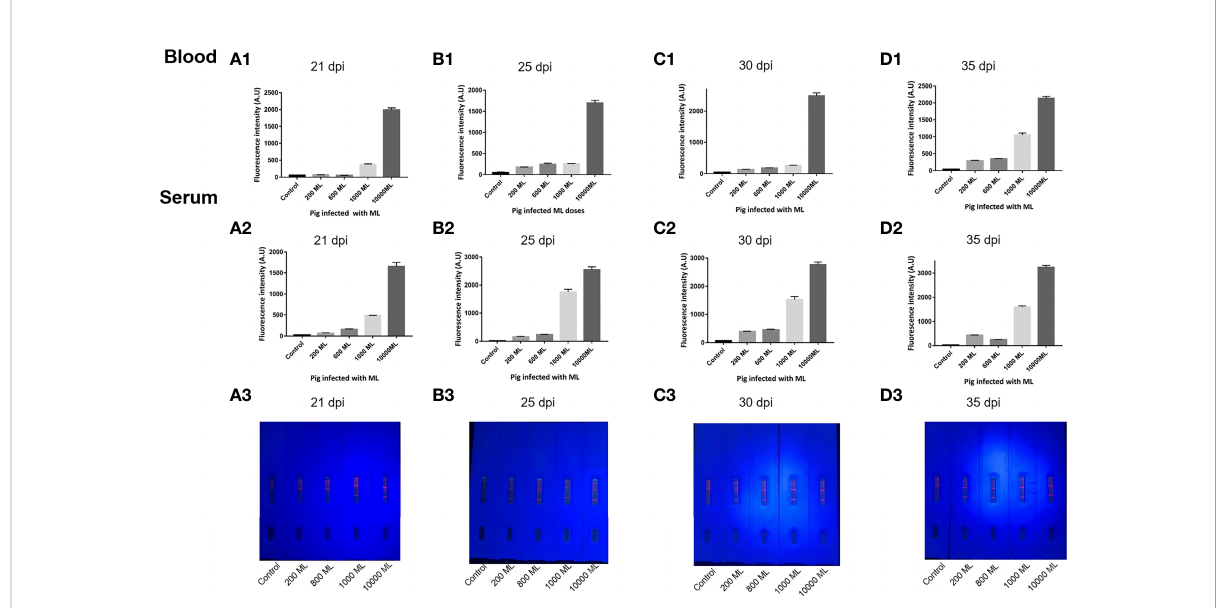
FIGURE 5 Comparison of ECM-ICS for detecting whole blood and serum samples. (A) Samples from pigs infected with Trichinella at 21 dpi. (B) Samples from pigs infected with Trichinella at 25 dpi. (C) Samples from pigs infected with Trichinella at 30 dpi. (D) Samples from pigs infected with Trichinella at 35 dpi. (A1, B1, C1, D1) ECM-ICS for detecting whole blood samples analyzed by the TRF reader ; (A2, B2, C2, D2) ECM-ICS for detecting serum samples analyzed by the TRF reade r; (A3, B3, C3, D3) the whole blood samples detected by ECM-ICS and the visual results under ultraviolet light.